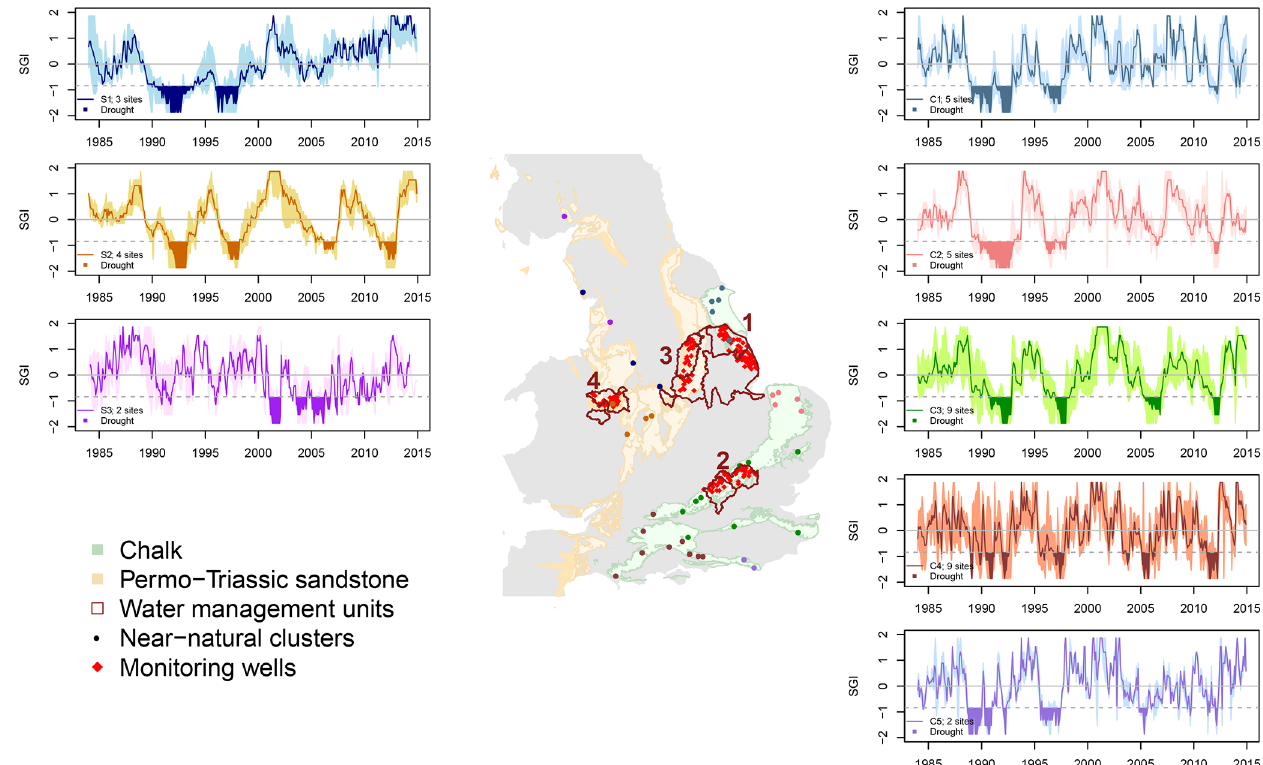
Figure 1. A total of eight clusters based on the 39 reference groundwater sites in the Permo–Triassic sandstone and chalk aquifer are shown, representing long-term, near-natural groundwater level variation. All time series are standardised for the 30 year time period (1984–2014). In the centre, locations of the reference wells are shown by the dots in different colours for all eight clusters. The four water management units are indicated in dark red (regular groundwater monitoring sites in red triangles). Three of these units coincide with the following reference clusters: 1 – Lincolnshire (C1), 2 – Chilterns (C3), and 4 – Shropshire (S2). S2 is also used to compare water management unit 3 (Midlands) as this is the nearest reference cluster in the Permo–Triassic sandstone. In the panels on the left (Permo–Triassic sandstone) and right (chalk), Standardised Groundwater level Index (SGI) time series are shown for each cluster, showing the cluster mean (thick line), the range of all reference wells in the cluster (shading), and reference droughts of the cluster mean (filled